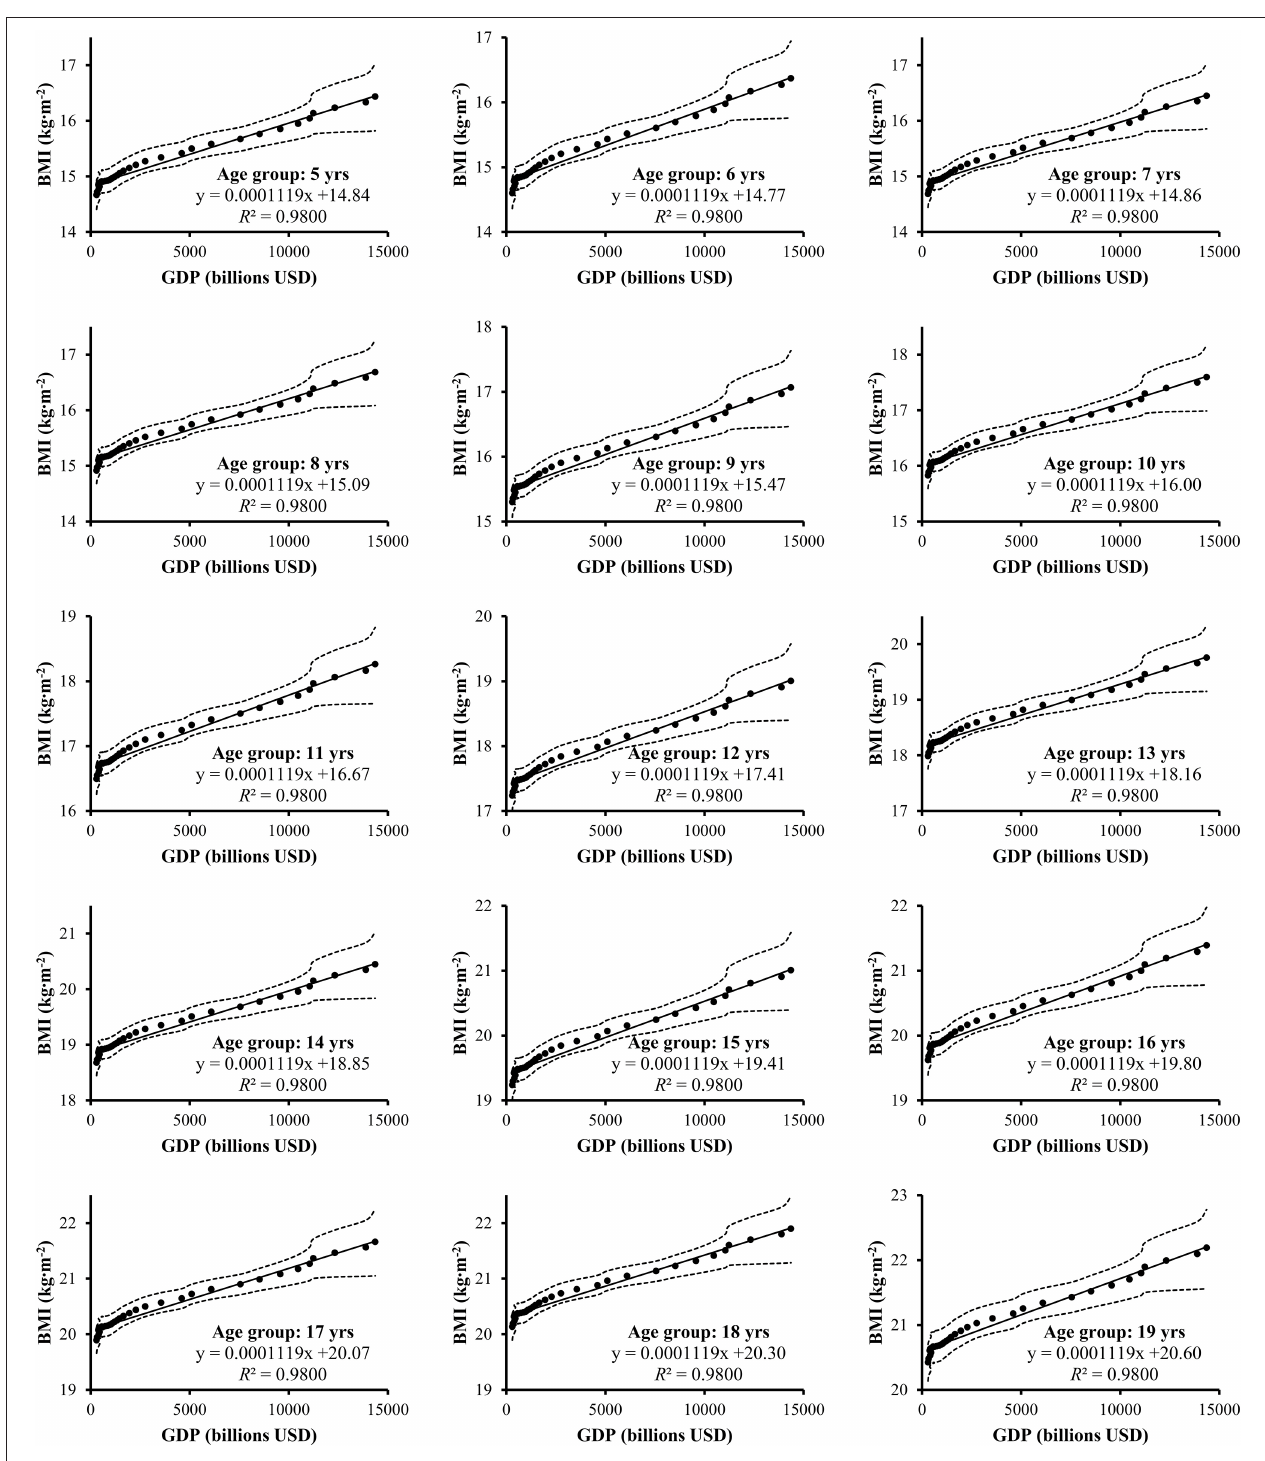
FIGURE 2 | Scatter plots with linear regression lines of gross domestic product (GDP) and body mass index (BMI) of Chinese girls aged 5–19 with respective Pearson correlation coefficients. Dotted lines represent 95% confidence interval. from 10.6 to 16.9% among girls. As the evidence century. For instance, Zhang et al. (21) found that between 2010 and 2015, the age-adjusted prevalence of overweight and obesity among boys increased from 21.2 to 31.7% and